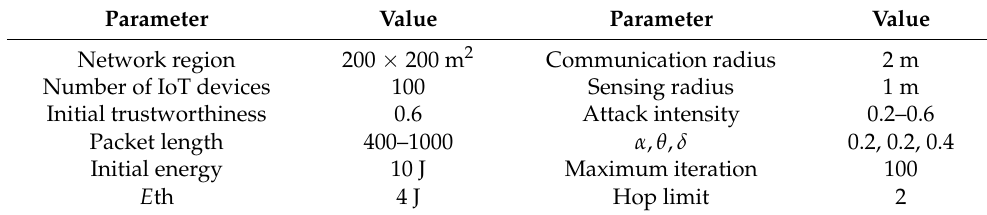
Table 2. The simulation network parameters. Parameter Value